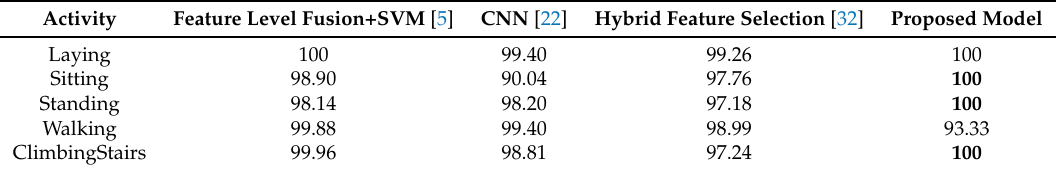
Table 4. Class-wise accuracy (%) comparison of the proposed model with other state-of-the-art models on the UCI-HAR dataset.